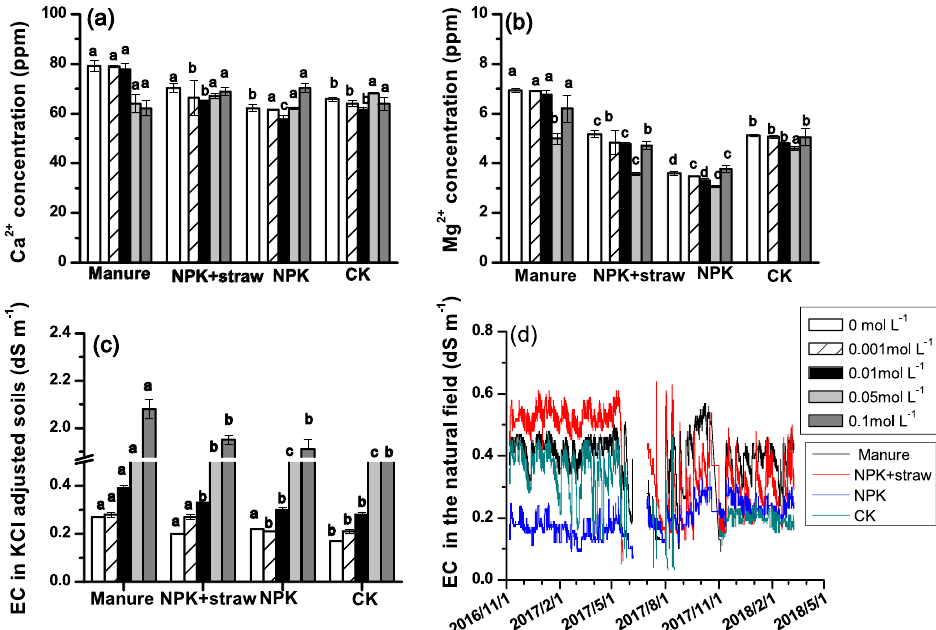
Figure 3. The solution information under four fertilization treatments ( a ) Ca 2+ concentration, ( b ) Mg 2+ concentration, ( c ) EC values in laboratory, ( d ) EC values in field. Different lower-case letters indicate significant differences of Ca 2+ , Mg 2+ and EC in laboratory among fertilization type under the same KCl concentration.